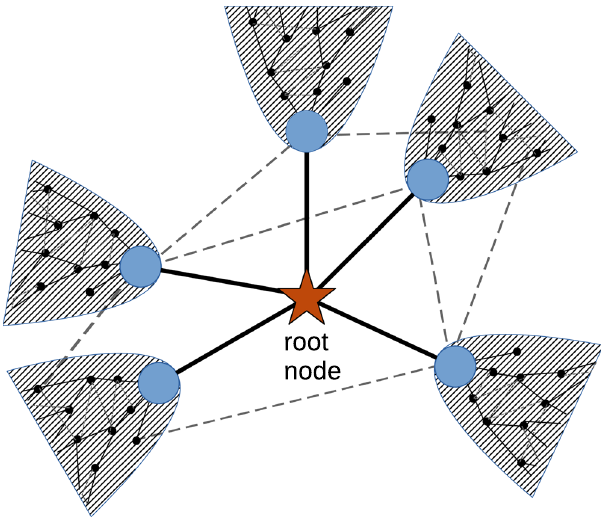
Fig. 1 An illustration of the shortest-path tree approximation. Every node r , here the red star, is considered to be the root node of a shortest-path tree T ð r Þ . This has k r nearest neighbours, as indicated by the fi ve solid black lines. Each of the neighbouring nodes, here the blue circles, is treated as the root of a branch of the shortest-path tree. These branches are treated as being statistically identical with a branching number ð 1 þ (cid:1) z Þ as indicated here through the use of the same shaded shape rooted on each neighbouring node. The grey dashed lines represent some of the many edges in the graph G that are not included in the shortest-path